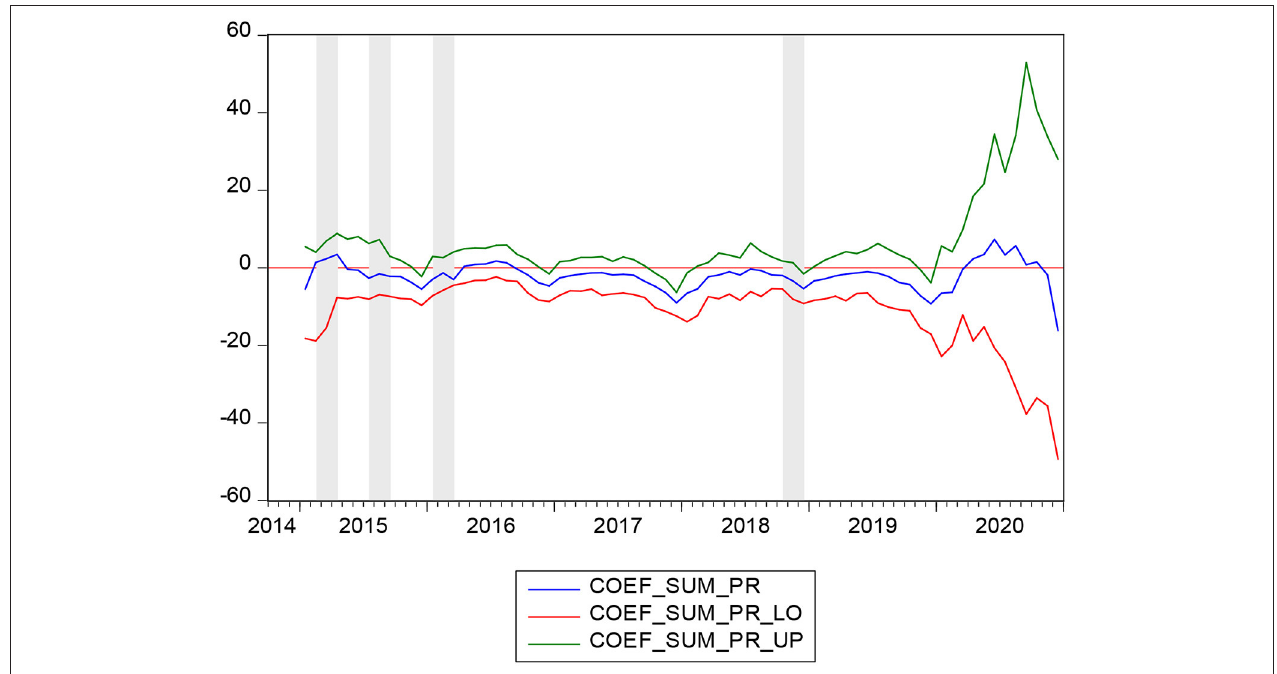
FIGURE 2 | Bootstrap estimates of the sum of the rolling-window coefficients for the impact of SMI on